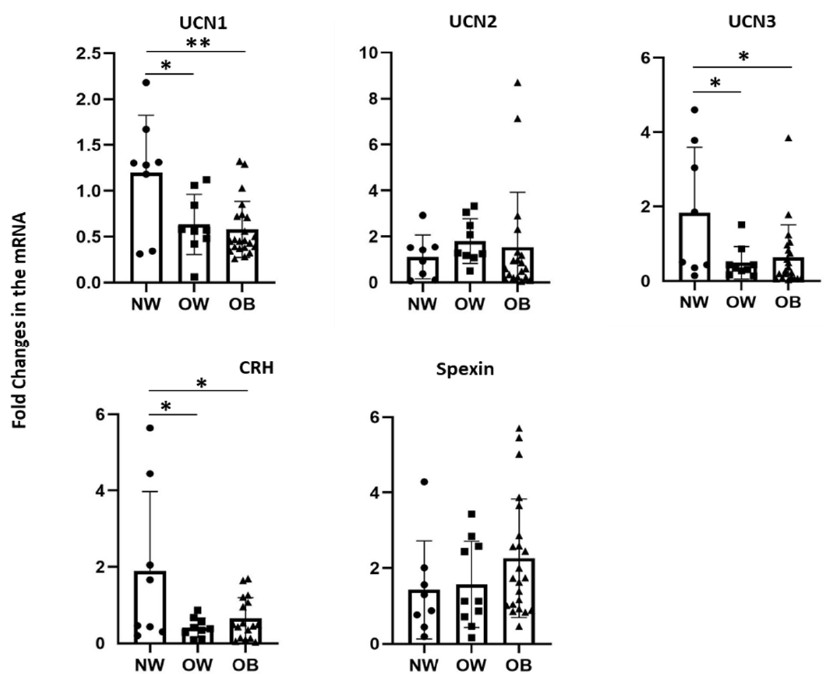
Figure 1. Gene expression levels in PBMCs according to body weight. mRNA expression levels of UCN1, UCN2, UCN3, CRH, and spexin were measured by quantitative real-time PCR in PBMCs from normal weight ( n = 8), overweight ( n = 10), and obese children ( n = 22). Data are normalized to internal GAPDH and presented as fold-changes compared with normal weight data. One-way ANOVA followed by Bonferroni ´ s post hoc test were used to determine the significance of difference in means between groups (* p < 0.05, ** p < 0.01). NW ( • ), OW ( ■ ), and OB ( ▲ ).